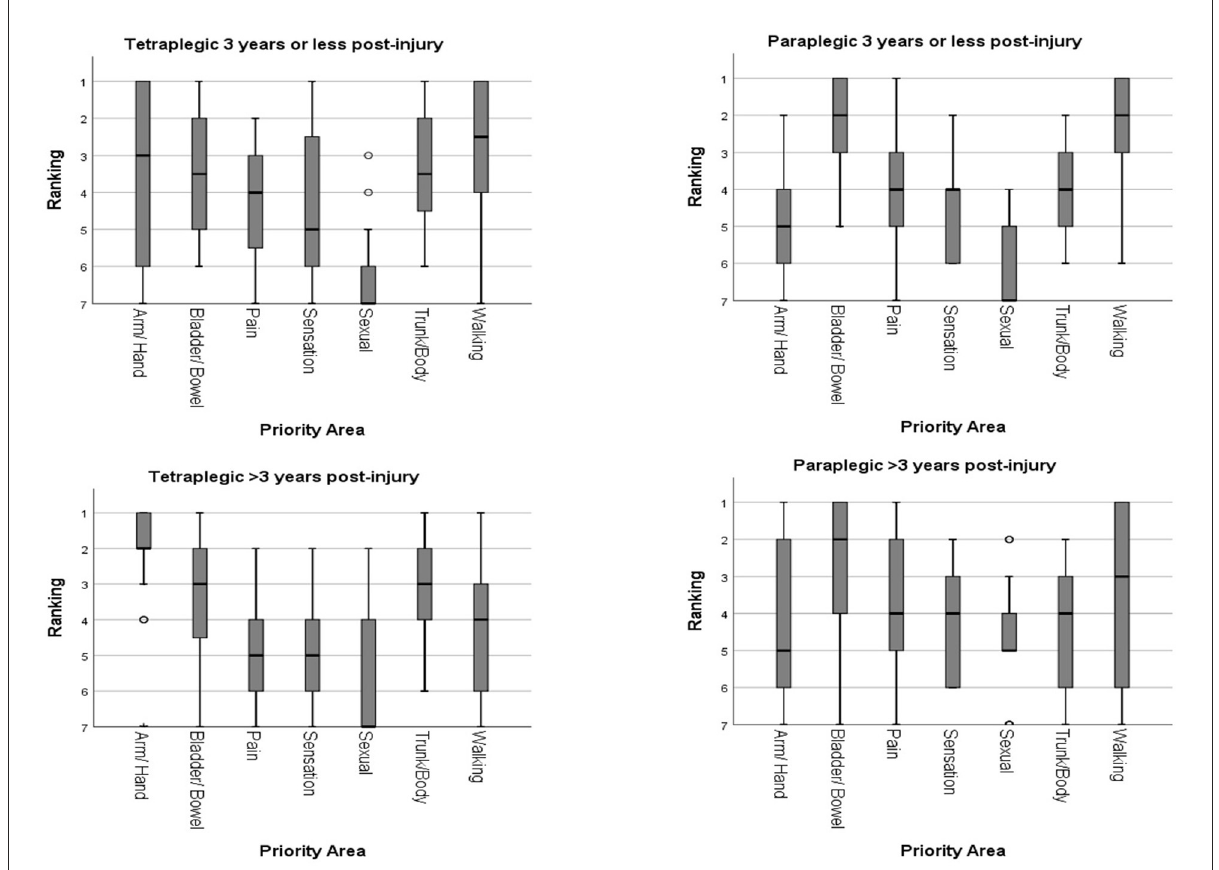
FIGURE3 Rankings of the priority areas of functional recovery according to different time post-injury.